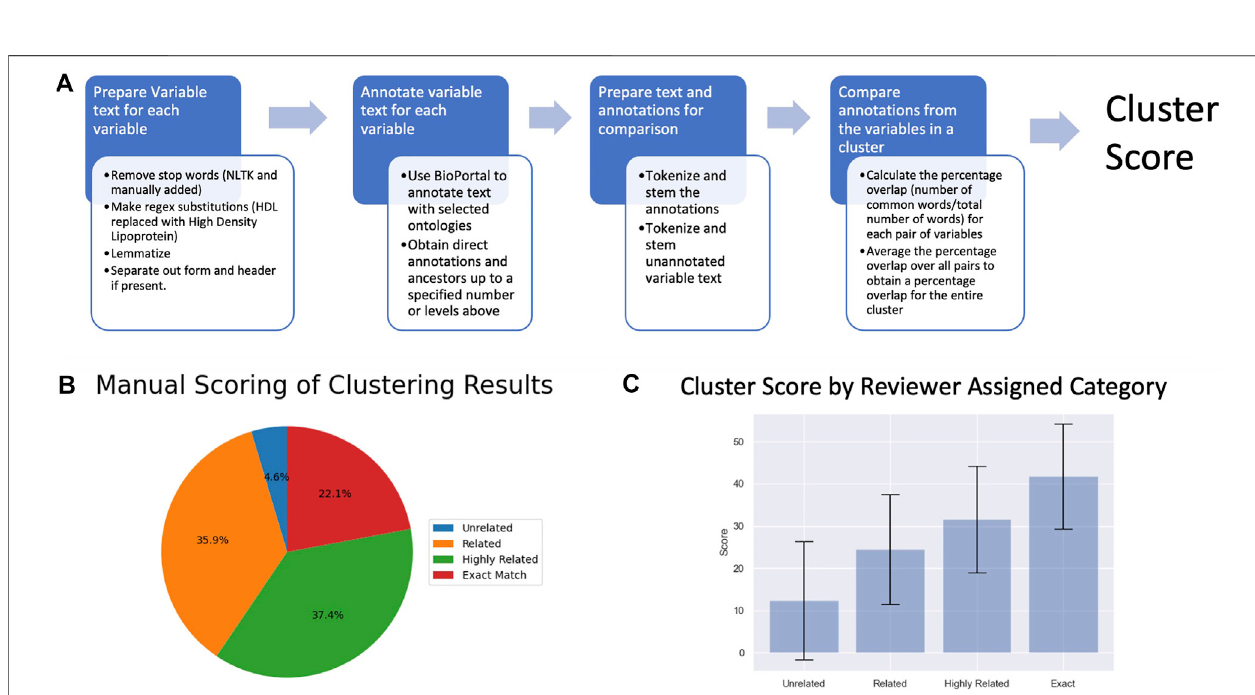
reviewers categorizing the clusters as Exact, Highly Related, Related, Unrelated or NA ( Table 1 ). In addition to the 391 clusters, 28 out of the 3,285 ARIC variables didn ’ t cluster with any other variables. Of the 391 clusters, 95.1% were determined by the reviewer to have some degree of relatedness and were classi fi ed as Exact, Highly Related, or Related. Only 4.6% were classi fi ed as Unrelated ( Figure 3B ). Examples of clusters in the different relatedness categories can be seen in Table 1 . Related clusters contained variables that are loosely related such as variables